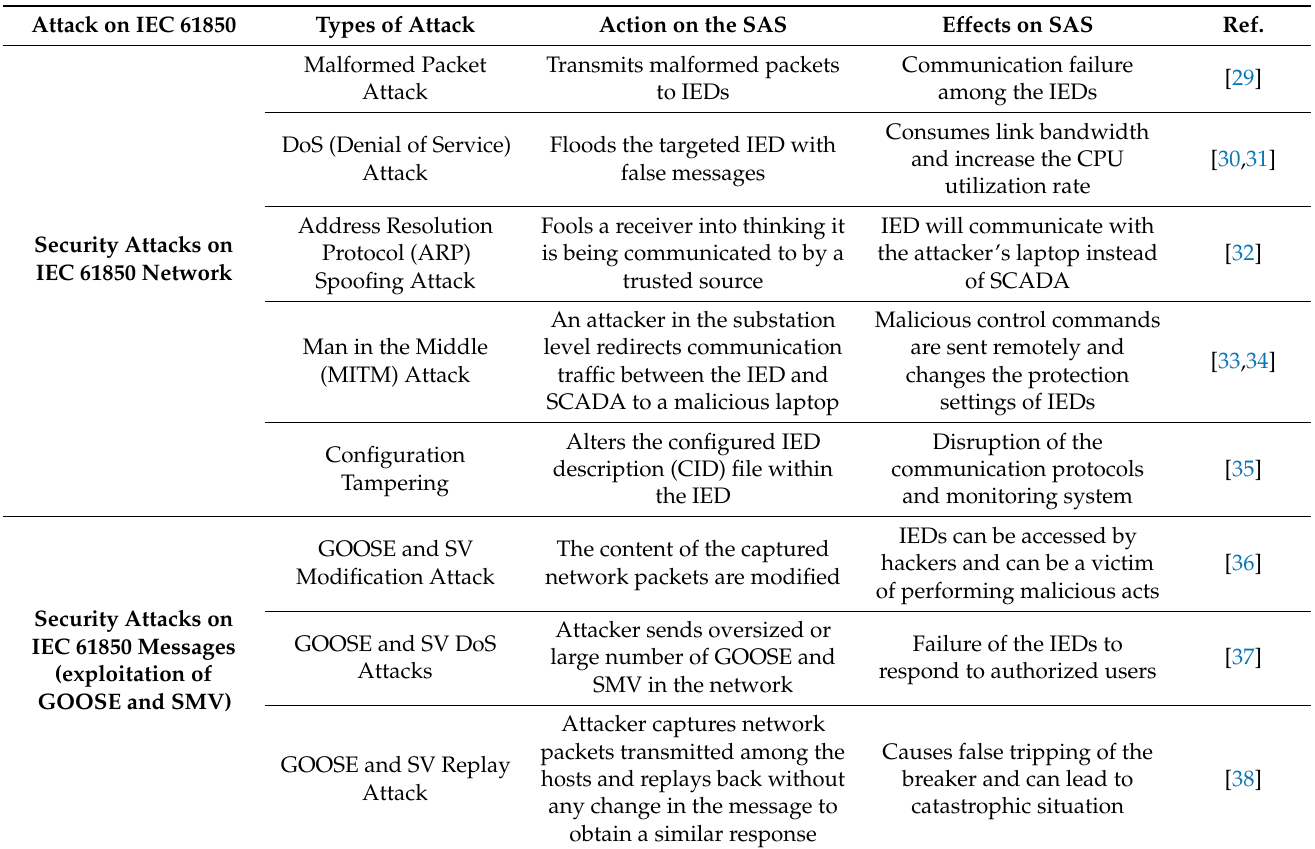
Table 2. List of attacks on IEC 61850-based